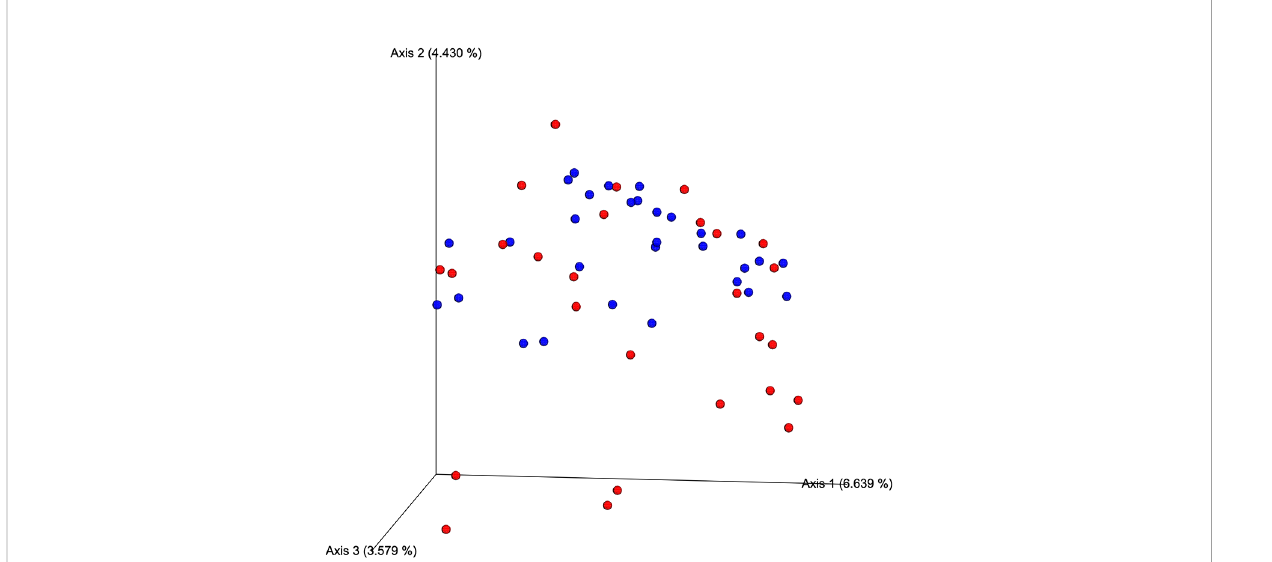
FIGURE 1 Qualitative measurement of the dissimilarity (Jaccard distance) of the microbial communities associated with of hypercholesterolemic individuals and controls. In the Principal Coordinates Analysis (PCoA), produced by EMPeror, hypercholesterolemic individuals are indicated in red, while those control individuals are indicated in